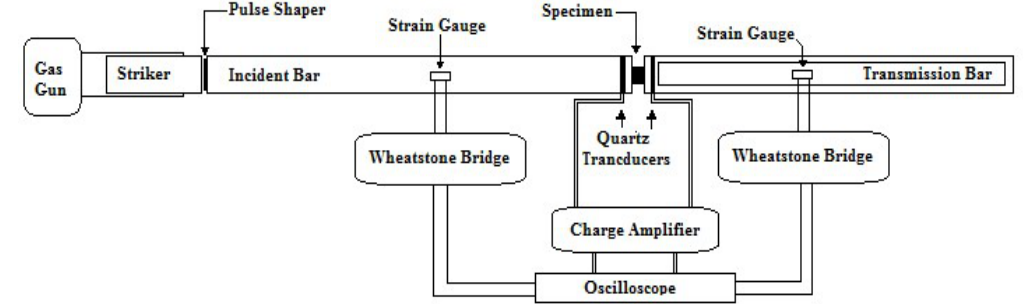
Figure 4. Schematic of the Kolsky bar apparatus used for high-strain rate testing of TPU samples.